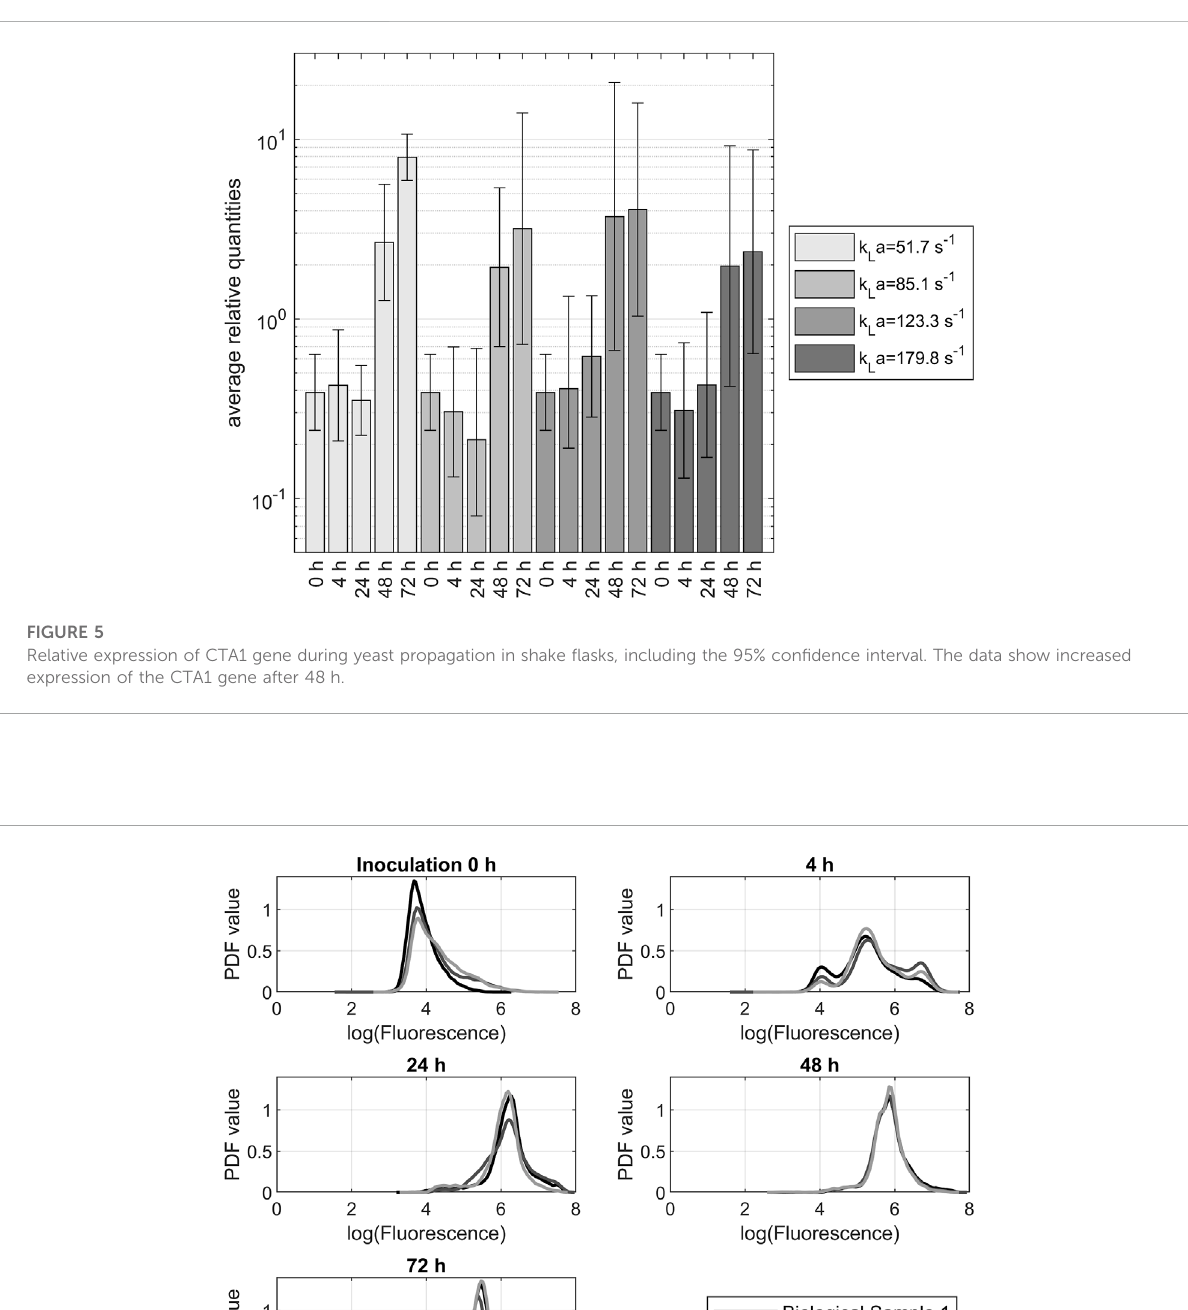
Frontiers in Chemical